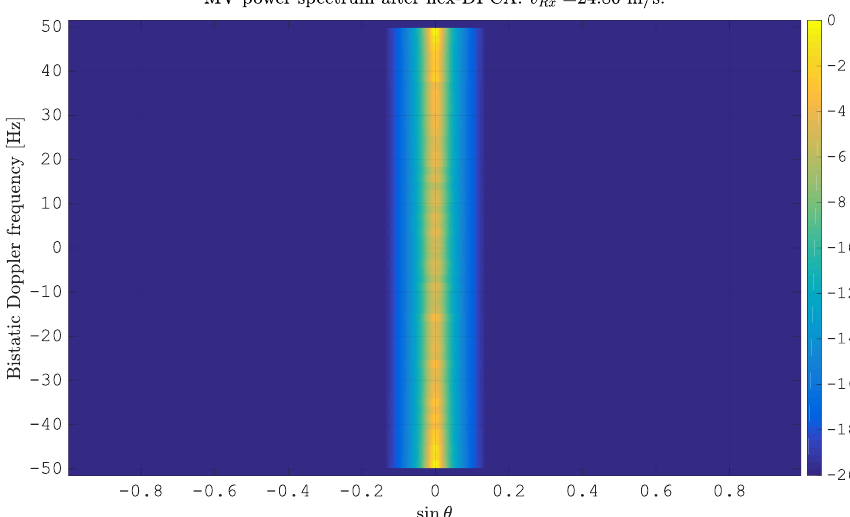
Figure 2. Minimum variance power spectrum estimated from simulated clutter for N = 2 spa- tially displaced antenna elements after motion compensation using flexible Displaced Phase Center Antenna